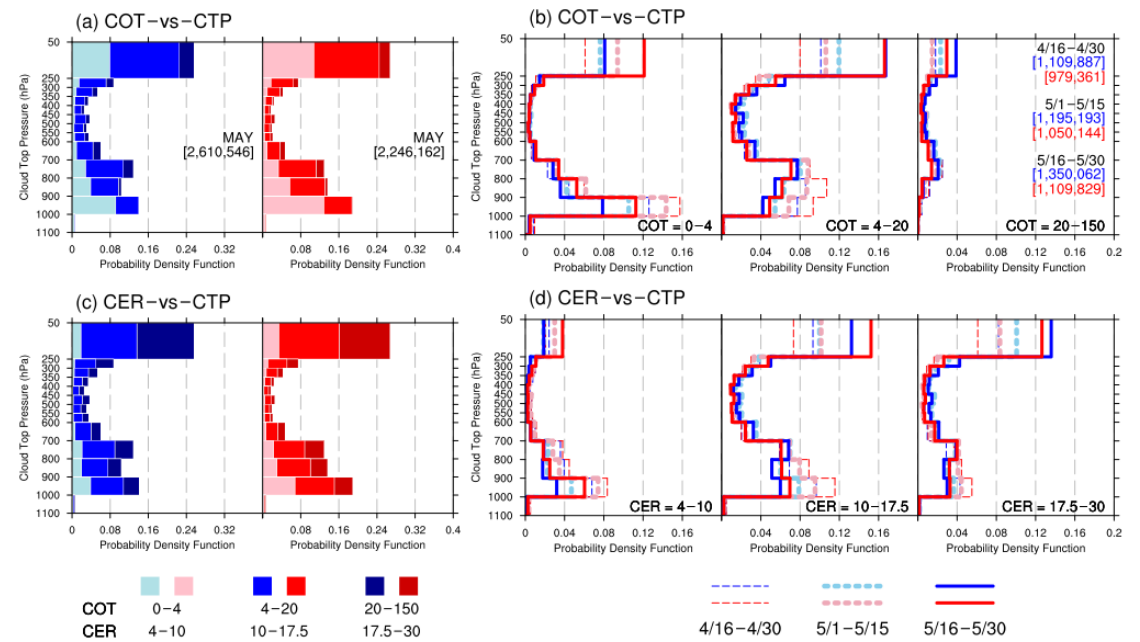
Figure 6. The monthly (May) and seasonal variation of the marginal probabilities of CTP with respect to three categories of ( a , b ) COT and ( c , d ) CER, respectively, compiled over the ICP as collected from cold (blue tone) and warm (red tone) years. The seasonal variation is revealed by the statistics of three 15-day periods from 16 April to 30 May of the cold and warm years. The numbers in square brackets are the total counts for these statistical periods; the total counts of CER are equal to COT. The COT and CER are for liquid water clouds in the daytime; COT is a dimensionless quantity, and CER is in µ m. The marginal probabilities of CTP are derived from the joint histograms of COT or CER binned against CTP. The COT is grouped into three categories of newly aggregated bins from the original COT histogram bins: 0–4, 4–20, and 20–150, whereas the CER are grouped into three categories of newly aggregated bins from the original CER histogram bins: 4–10,10–17.5, and 17.5–30. Three sets of the marginal probabilities of CTP are obtained by integrating the joint probability (relative frequency) over the specific ranges of the aggregated bins from the three corresponding COT or CER categories, respectively. ( a , c ) The marginal probabilities of May displayed as stacked histograms. ( b , d ) The marginal probabilities of 15-day periods displayed as overlapping histograms, with each plot panel for each individual category. The x -axis is probability, the y -axis is CTP.